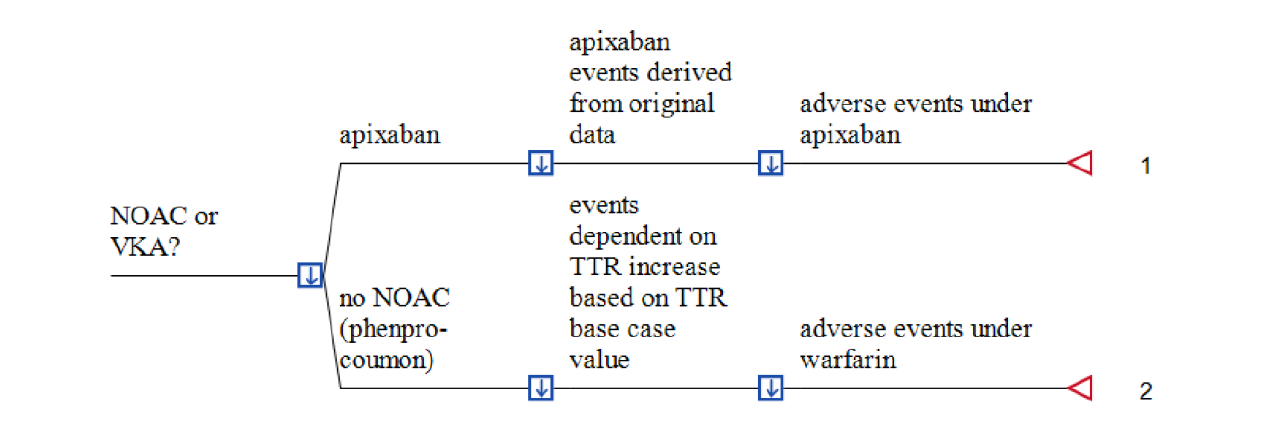
Figure 1. Section of the probabilistic cost-benefit decision tree of administering apixaban versus VKA plus PST in AF